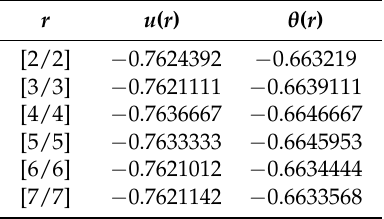
Table 3. Numerical comparison of HAM, ND-Sole Methods and Adomian decomposition method (ADM) for